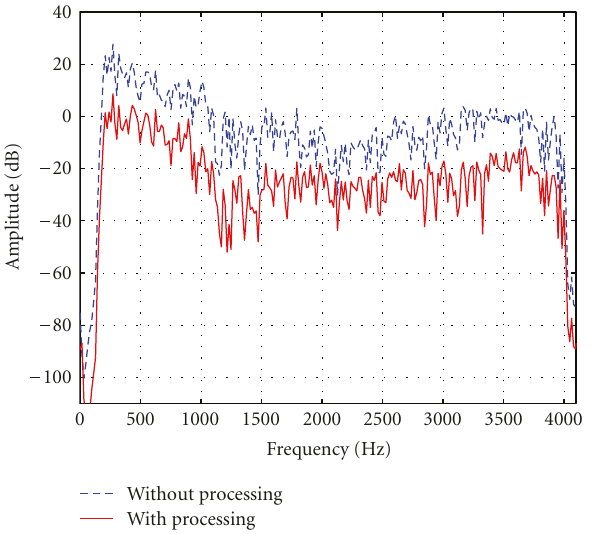
Figure 4: Example of frequency characteristics of observed signal obtained by acoustic echo canceller. The signal is observed at the microphone near the user. The position of interference is number 1 in Figure 3.